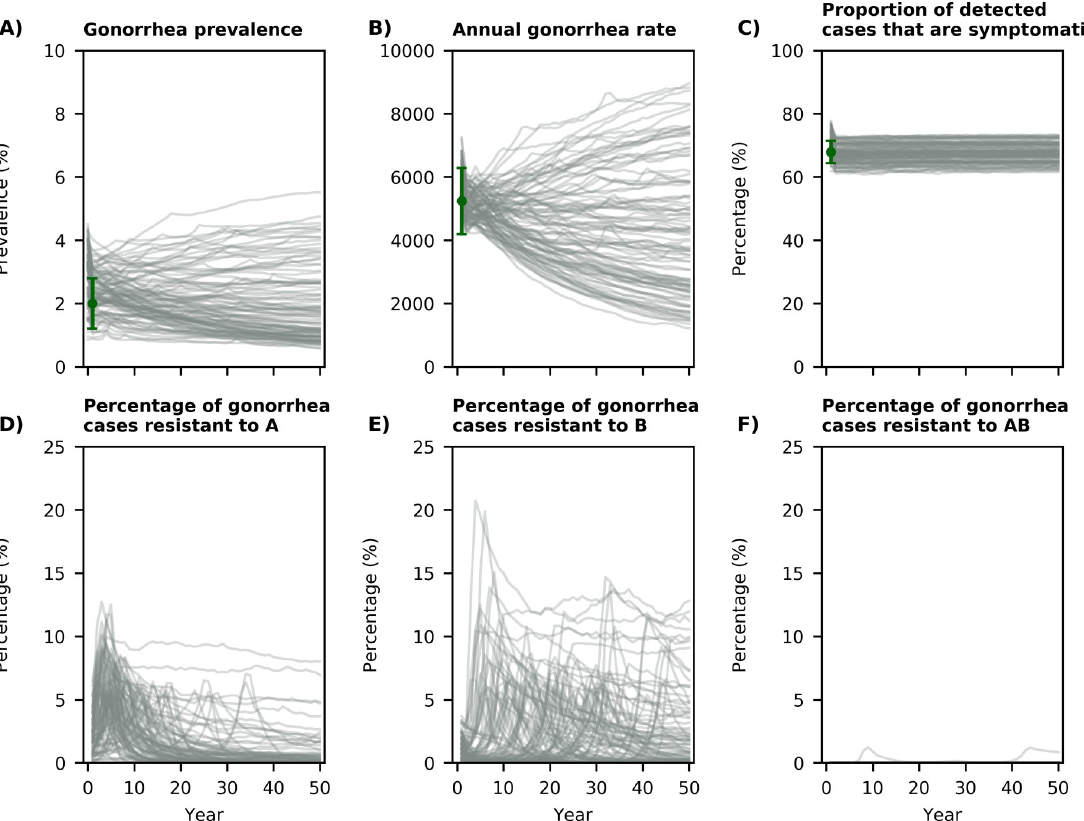
Fig 2. Displaying 100 simulated trajectories from the calibrated model. The green dots in panels A–C represent the data or estimates the model is calibrated against: gonorrhea prevalence (2.0% [1.2%, 2.8%] [18,19] of MSM), the estimated rate of gonorrhea cases in 2017 (5,241.8 cases per 100,000 MSM [1]), and the proportion of gonorrhea cases among MSM that are symptomatic (67.9% [64.4%–71.4%] [20]). In these simulated trajectories, the first-line treatment is changed when more than 5% of the annual gonorrhea cases are resistant to the first-line drug. MSM, men who have sex with